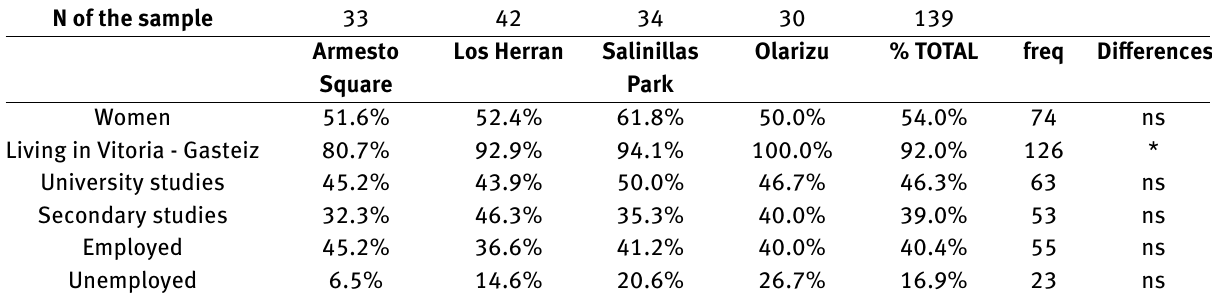
Table 1: Characteristics of the sample group of participants in the demonstrative exercise in Vitoria-Gasteiz and in each place. N of the